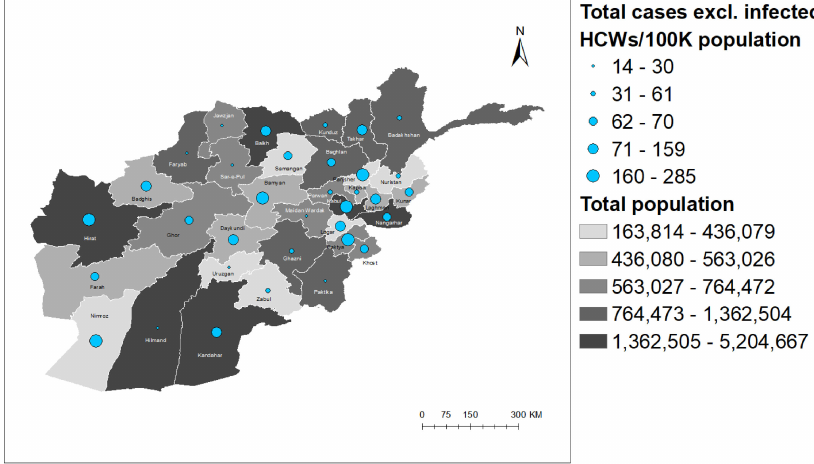
Fig. 3 A map of Afghanistan showing the distribution of total COVID-19 cases excluding infected HCWs per 100,000 population by provinces from February 24, 2020 to November 03, 2020.